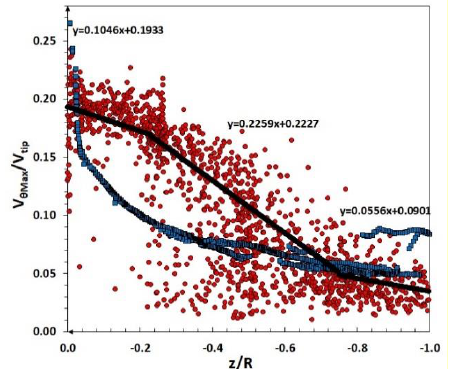
Figure 17. The maximum values of the non-dimensional swirl velocity for each vortex detected. Comparison between the experiment (red) and the numerical simulation (blue). The black lines are the linear interpolation of the experimental data on three separate zones (0 ≥ z/R ≥ − 0.23; − 0.75 ≥ z/R ≥ − 0.23; − 0.75 ≥ z/R ≥ −